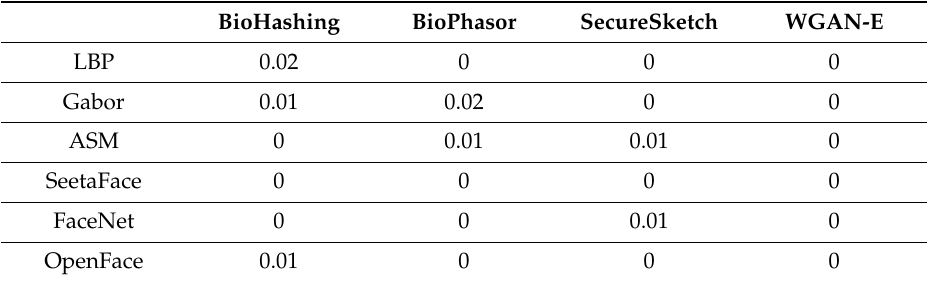
Table 6. When the key is not known by the impostor, equal error rate.